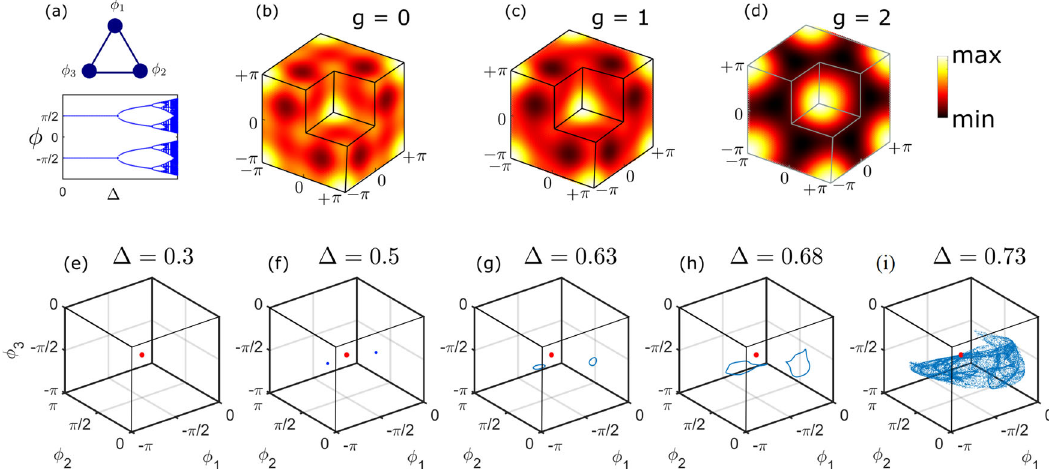
Fig. 2 Adiabatic deformation and chaotic annealing mechanisms. For a 3-oscillator network ( a ), the potential landscape is shown in ( b – d ) for different gain levels g , and the dynamics is depicted in ( e – i ) for different discretization time steps Δ . These two parameters form the basis of the adiabatic deformation and chaotic annealing mechanisms that assist the optimization search process. a – c The local minima are shallower for lower than higher gains, which facilitates escaping the local minima when the gain is adiabatically increased. d – h The route to chaos as a result of increasing discretization time step, which creates the possibility of harnessing chaos for dynamical complexity in the optimization process. The chaotic map of a single oscillator for q = 2 (bi-stable oscillators) showing the oscillator ’ s phase ϕ versus discretization time step is also depicted in ( a